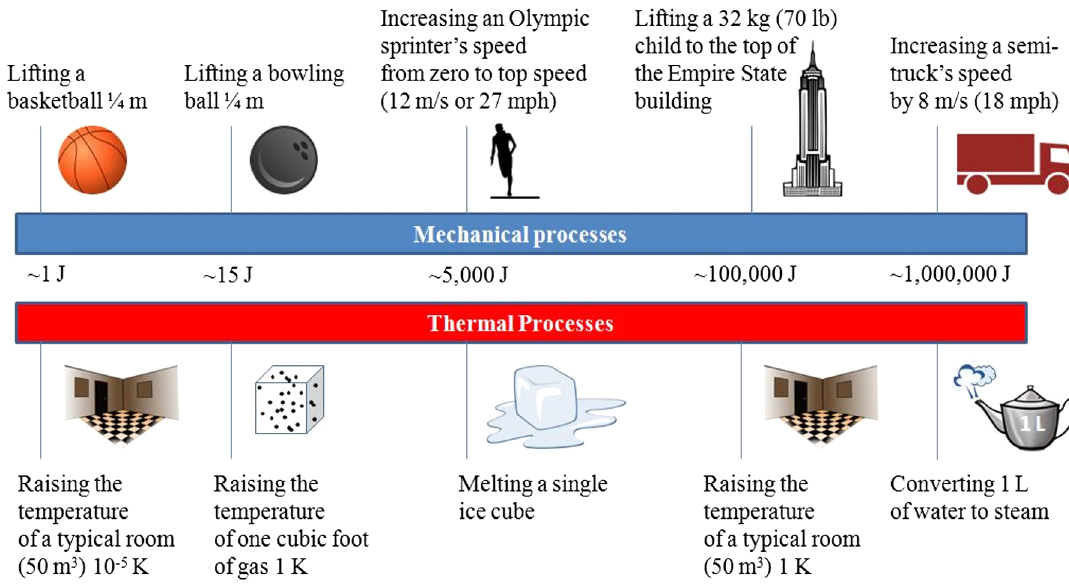
FIG. 1. A comparison of the energy associated with various thermal and mechanical